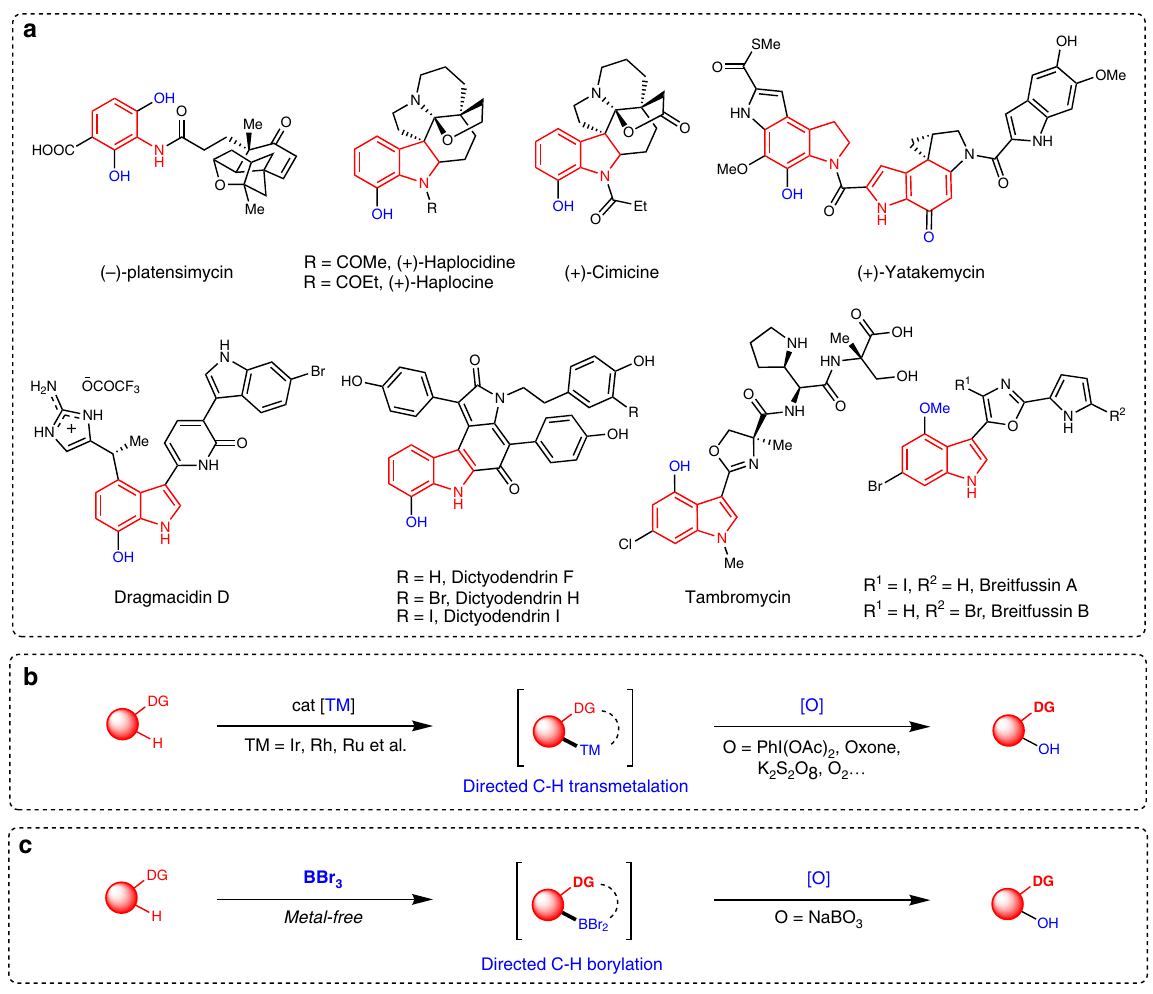
Fig. 1 Towards a transition-metal-free process for directed aromatic C – H hydroxylation. a Phenol-based bioactive molecules. b Transition-metal- catalysed directed aromatic C – H hydroxylation. c Our approach for directed aromatic C – H hydroxylation under transition-metal-free